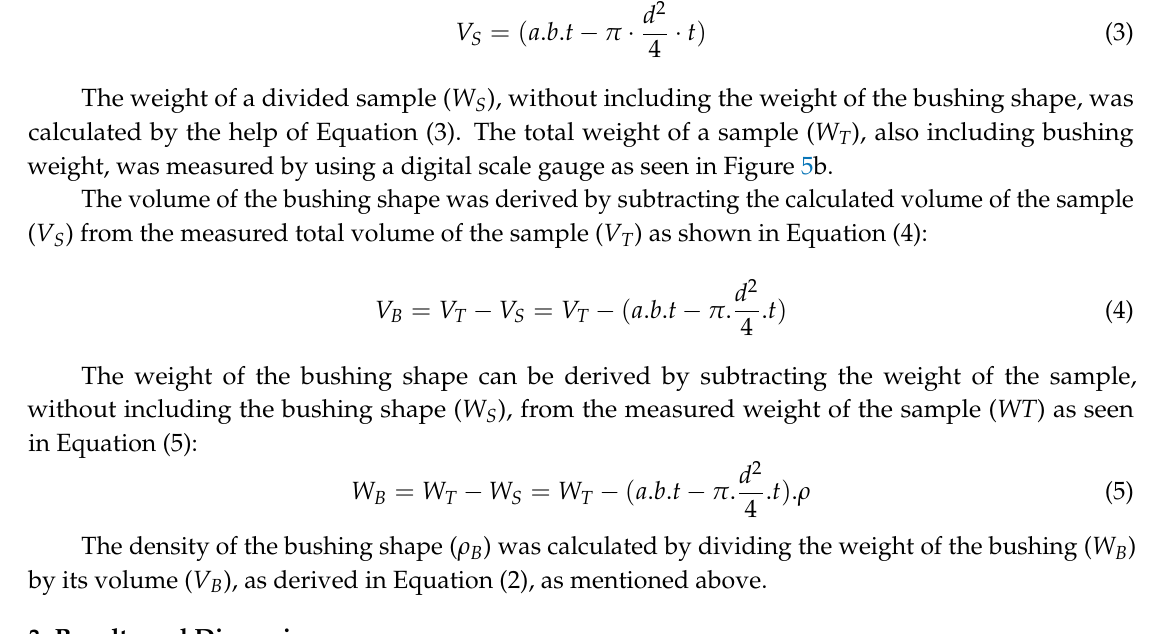
Figure 5. Geometrical properties of samples.